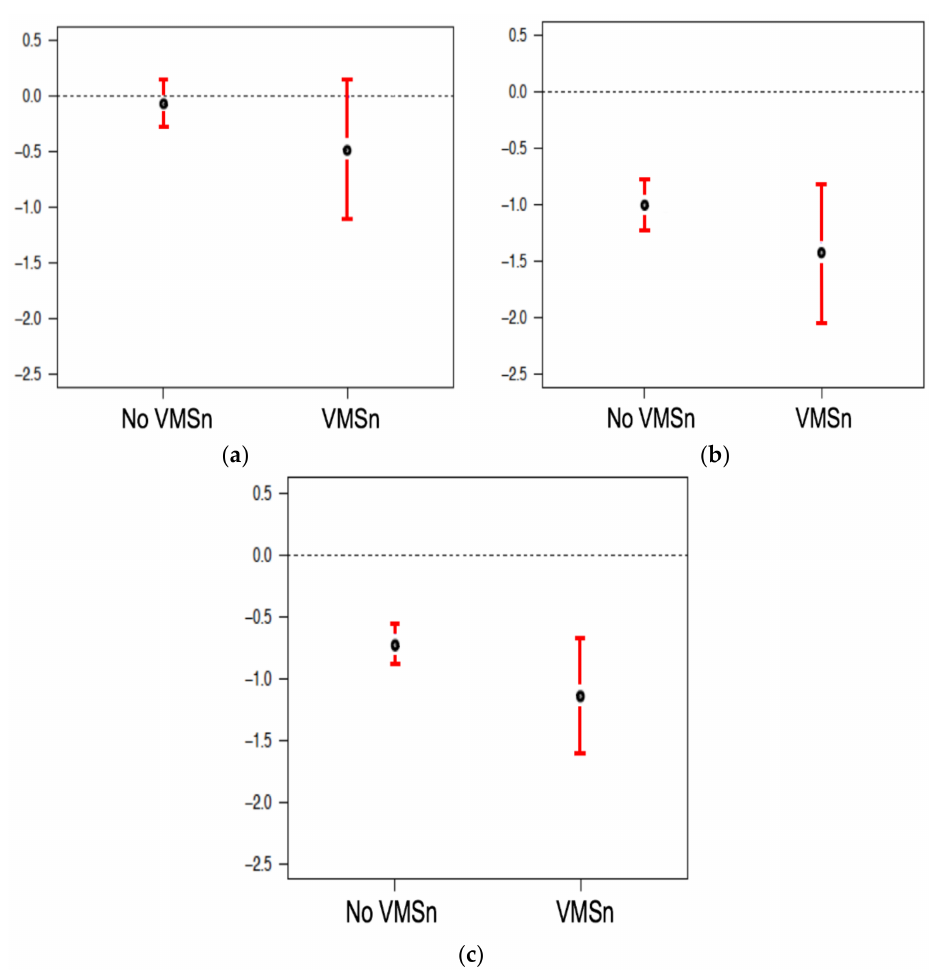
Figure 1. Two-year mean Percentage Changes in areal Bone Mineral Density values (BMD 95% CI) by Experience of Clinically Important Night Sweats (VMSn) or mild or absent VMSn (No VMSn) in Women ages 43–63 in the Canadian Multicentre Osteoporosis Study (CaM os ) at: ( a ) L1-4 spine BMD; ( b ) FN BMD; ( c ) TH BMD